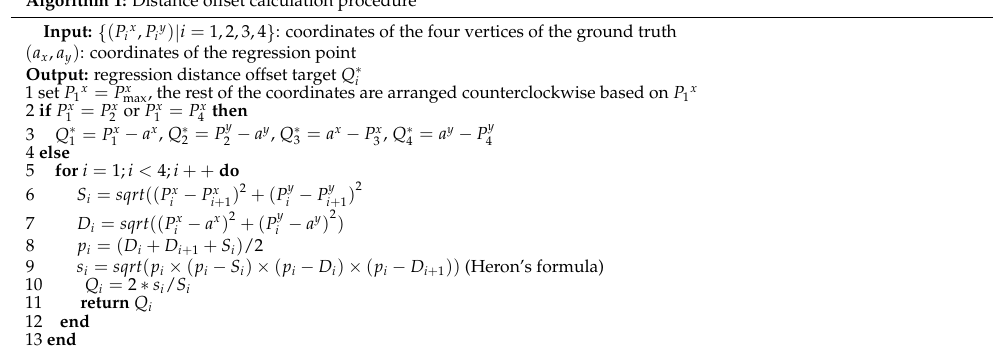
Algorithm 1: Distance offset calculation